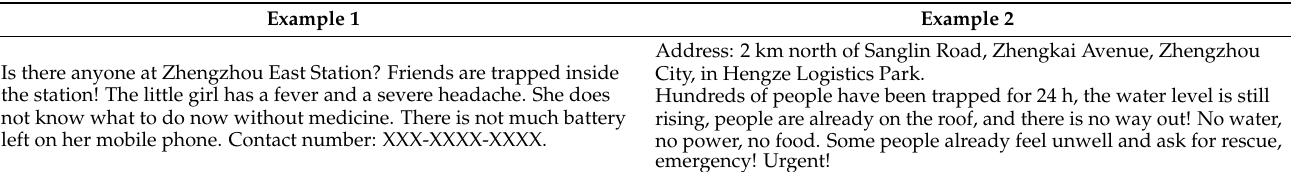
Table 1. Examples of SOS messages.